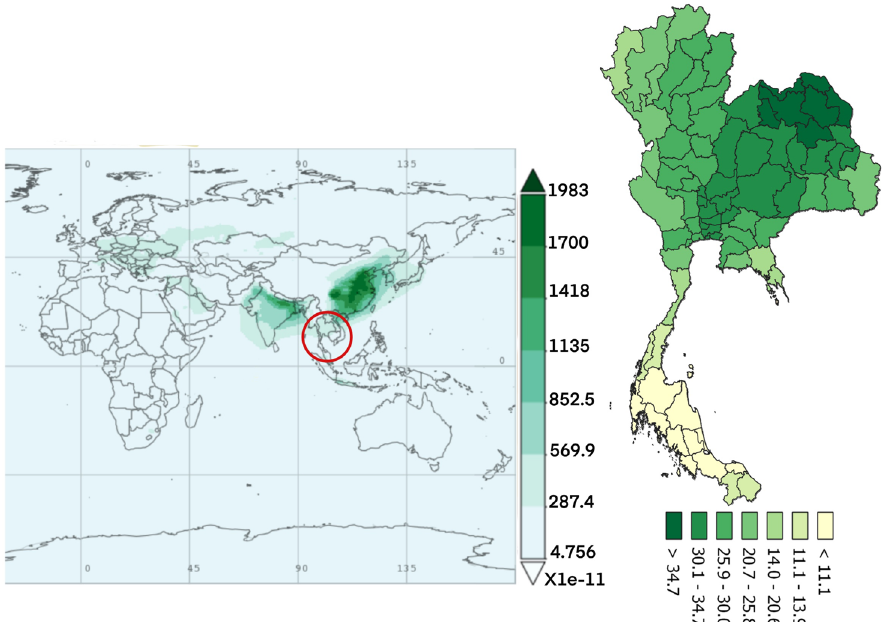
Figure 7. The average time of SO 4 concentration monthly over 2010–2016. (The world map was generated by Giovanni Version 4.34: a free and open source earth data, https ://giova nni.gsfc.nasa.gov/giova nni/) and accumulated dose between 2010 and 2016 in Thailand (Thailand map was generated by QGIS software: a free and open source geographic information system, https